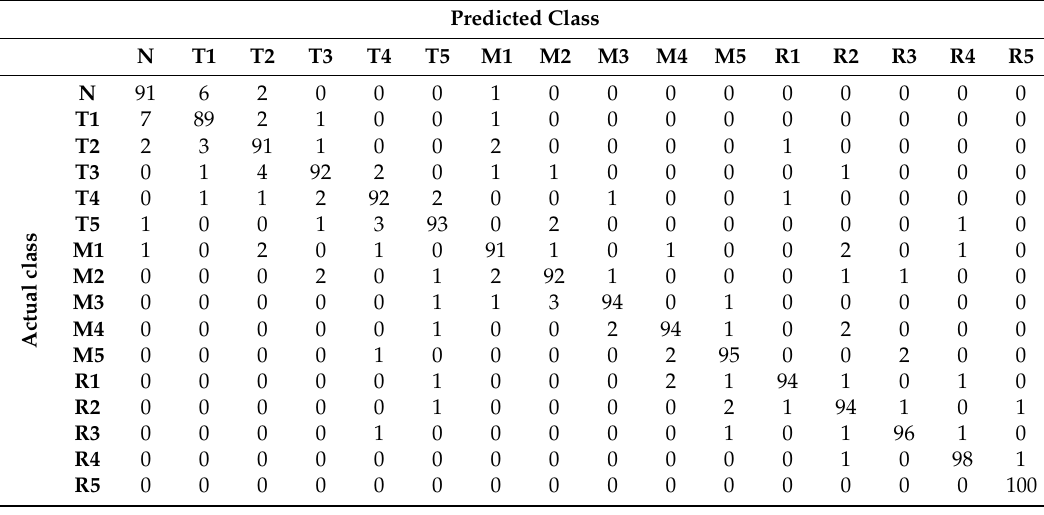
Table 7. Experimental